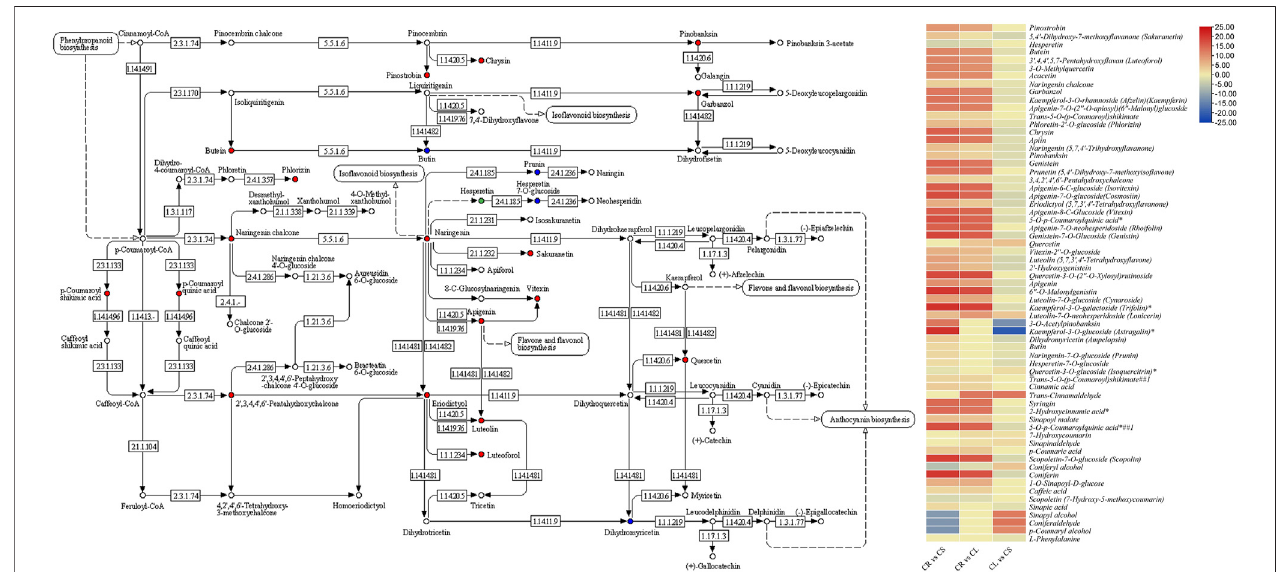
FIGURE 3 | Flavonoid biosynthesis pathway showing enriched DAMs between CS and CL. The heatmap on the right shows the log2 fold change values of the DAMs enriched in the fl avonoid biosynthesis pathway in the three tissue comparisons. CL, leaf; CS, stem; CR, tuber.